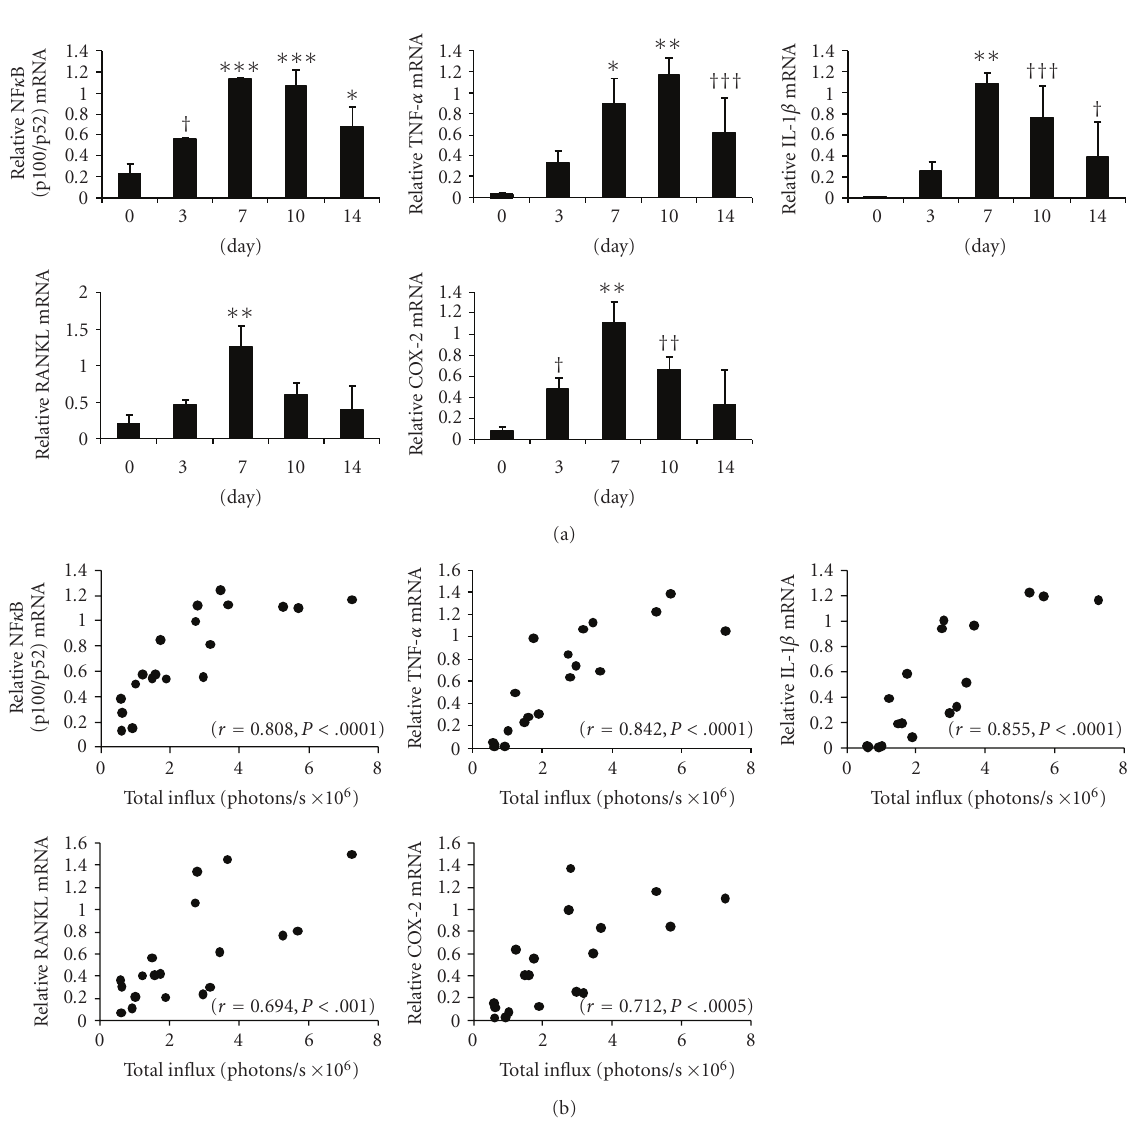
Figure 4: (a) The mRNA levels of NF κ B (p100/p52), TNF- α , IL-1 β , RANKL, and COX-2 in calvarial tissues retrieved on the indicated days and subjected to real-time RT-PCR ( n = 3-5 per bar, Mean ± SD, † P < . 05, †† P < . 01, ††† P < . 005 ∗ P < . 001, ∗∗ P < . 0005, ∗∗∗ P < . 0001 versus value on day 0). (b) Correlation between total influx and mRNA levels of NF κ B (p100/p52), TNF- α , IL-1 β , RANKL, and COX-2. The correlation coe ffi cient and P values were r = 0 . 808, P < . 0001 for NF κ B (p100/p52); r = 0 . 842, P < . 0001 for TNF- α ; r = 0 . 855, P < . 0001 for IL-1 β ; r = 0 . 694, P < . 001 for RANKL; r = 0 . 712, P < . 0005 for